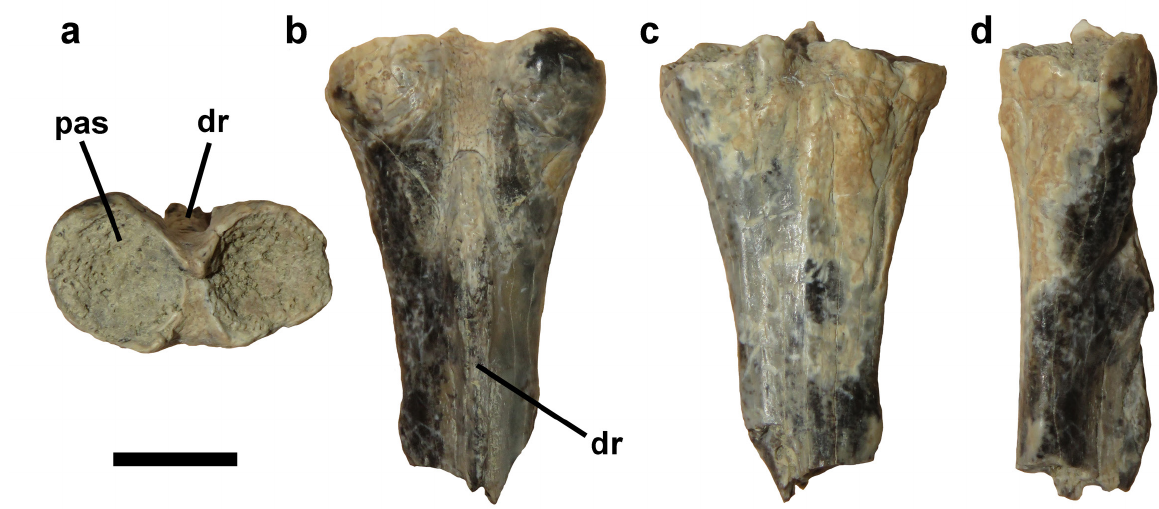
Figure 8. Indeterminate Calyptocephalellidae. a-d, LIEB-PV 8008, incomplete urostyle in a, anterior; b, dorsal; c, ventral; and d. right lateral views. References: dr, dorsal ridge; pas, proximal articuar surface. Scale bar: 1